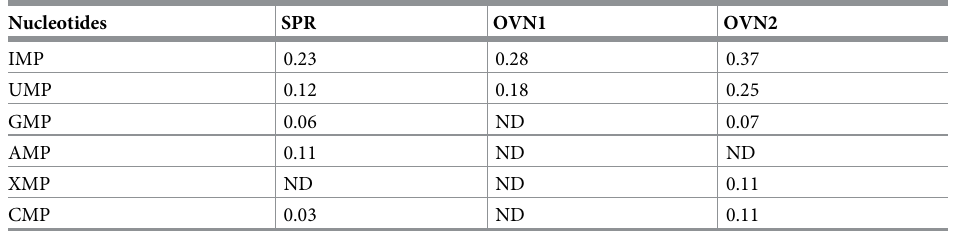
Table 7. Nucleotide concentrations of three different types of BSFL (%